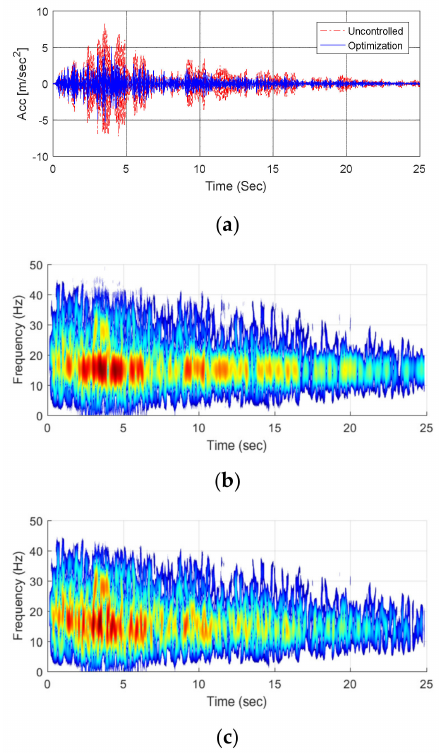
Figure 29. Results of time–frequency analysis of the electrical cabinet subjected to San Fernando: